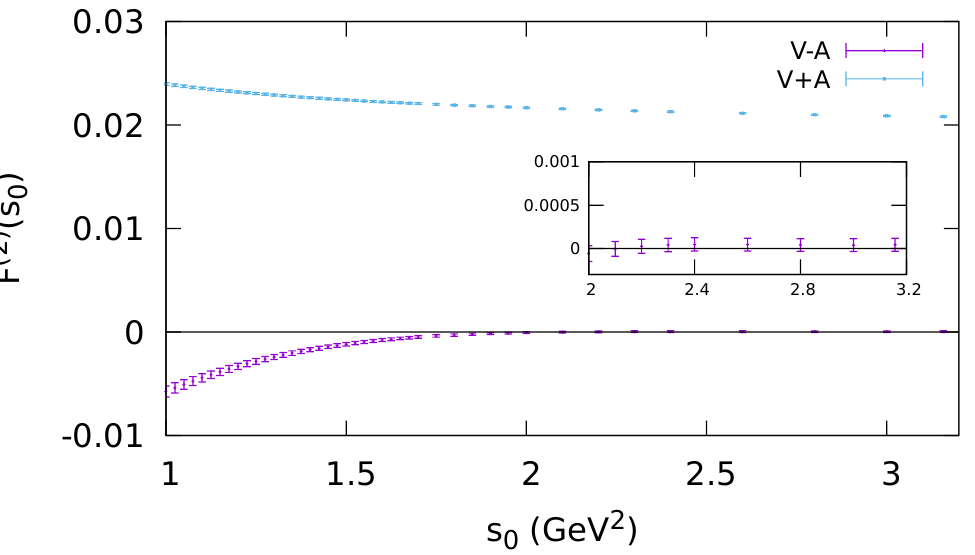
Figure 7 . F (2) ( s 0 ) as defined in eq. (6.26). The error bars include the experimental uncertainties V ± A and the theoretical errors associated with hO d